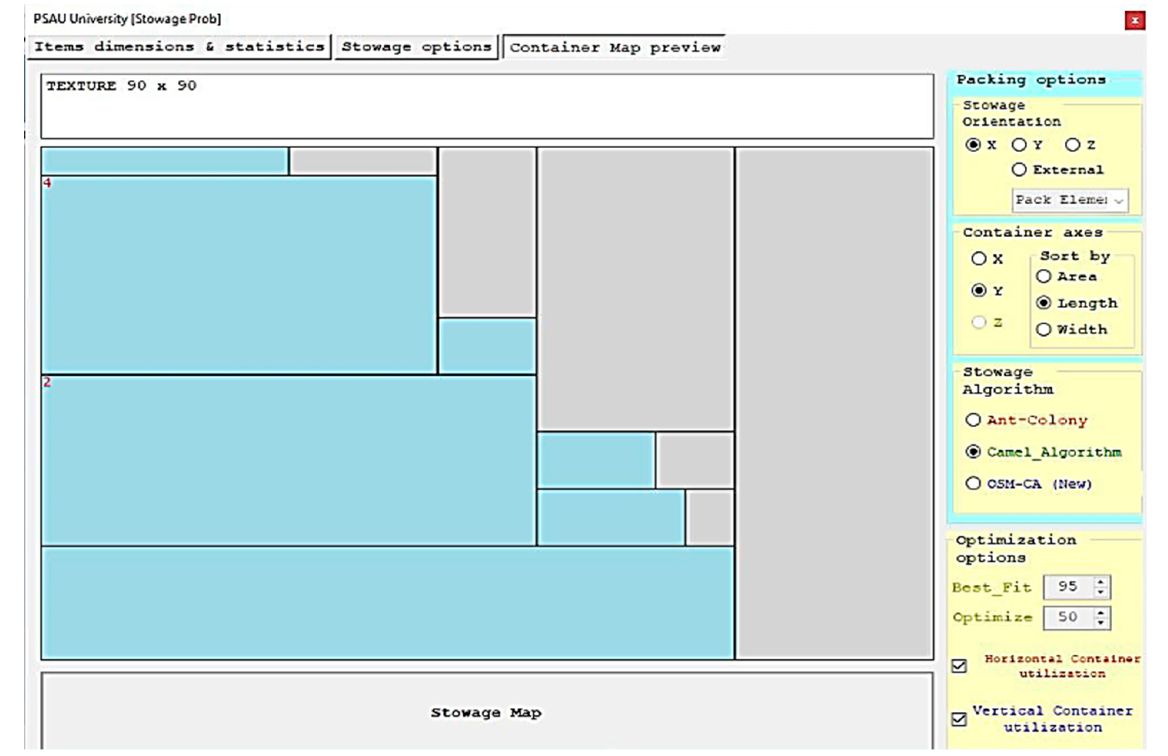
Figure A4. The stowage map for nine objects by the ant-colony algorithm optimization for first sta- tion on the distribution path.